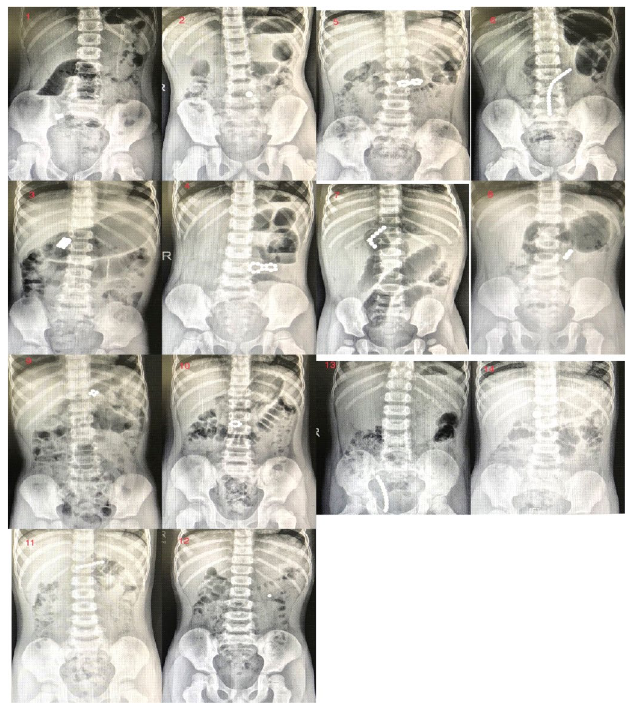
Figure 1. Abdominal X-rays of the 14 children with different number and different locations of the misingested magnets/magnetic beads (please refer to Tables 1, 2 in